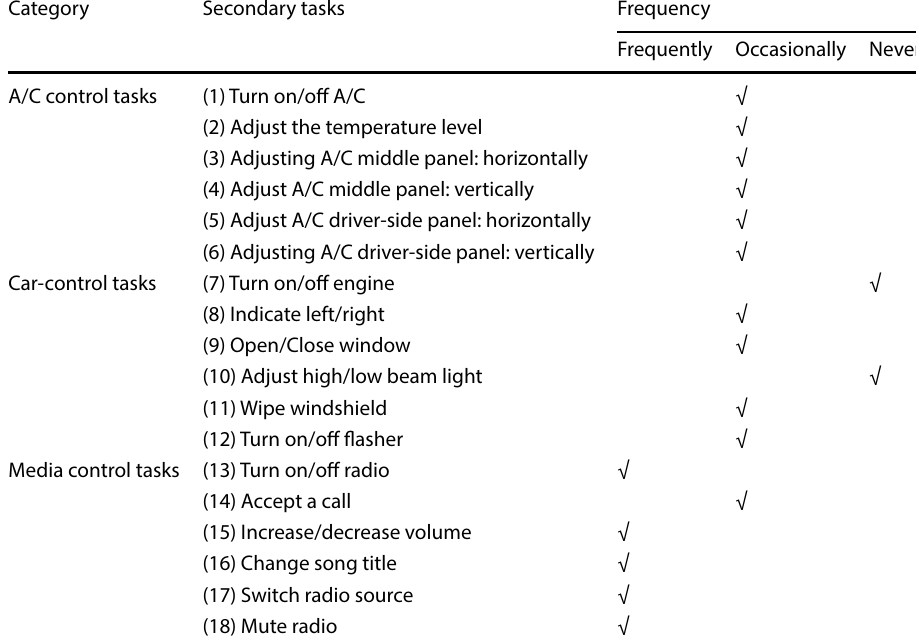
Table 1 The frequency of use of major driving secondary tasks modified from